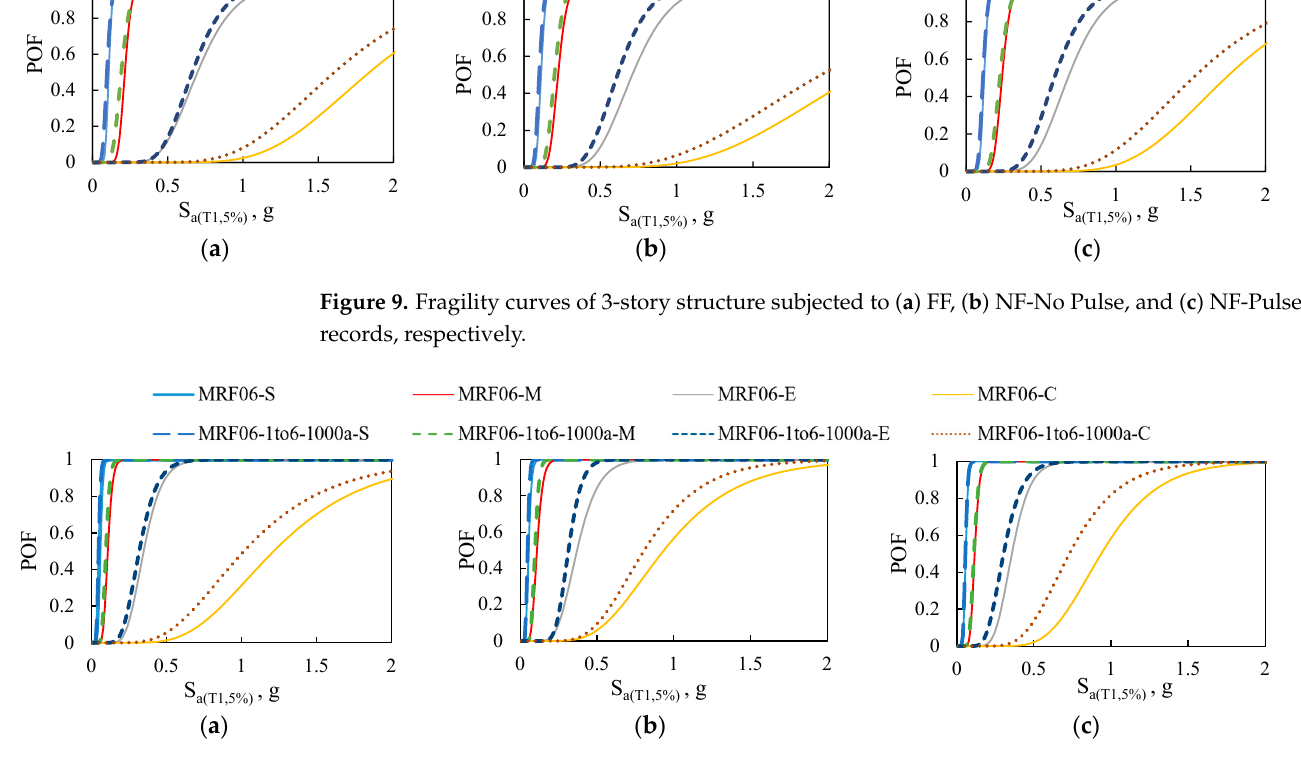
( c ) Figure 11. Fragility curves of 9-story structure subjected to ( a ) FF, ( b ) NF-No Pulse, and ( c ) NF-Pulse records, respectively. Generally, earthquakes following fire has an apparent effect on the performance of all frames at different PLs. The increase in the height of the structure raises its vulnerability to seismic loading after a fire incident. The POFs for post-fire and the initial case in the spectral acceleration at the fundamental period, S a(T1) , are computed to be 0.52 and 0.45 in